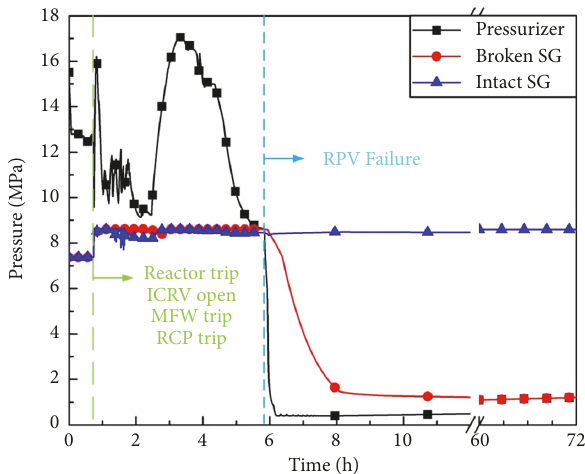
Figure 8: Released steam mass through MSSV in the base case.